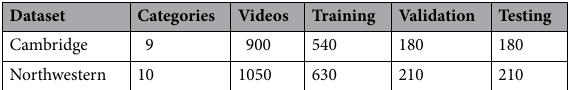
Table 1. Specific information of the data set used in the experiment.